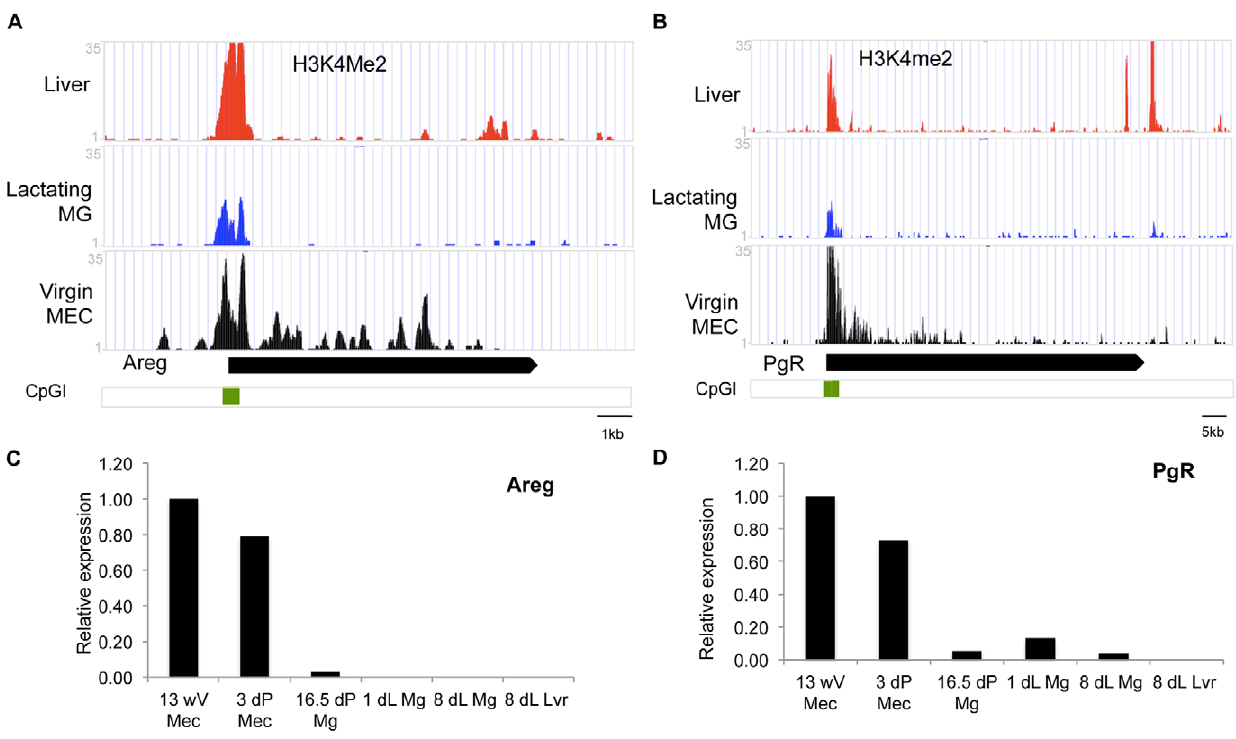
Figure 8. H3K4me2 ChIP-seq and RT-PCR results for genes expressed in virgin mammary gland. ( A–B ): ChIP-seq reads for H3K4me2 in liver tissue ( Liver , red), lactating mammary glands ( Lactating MG , blue) and mammary epithelial cells isolated from 12 week virgin mammary glands ( Virgin MG , black). ( C–D ): Q-RT-PCR of ( C ) Amphiregulin (Areg) and ( D ) Progesterone receptor PgR at different developmental stages in MEC isolated from mammary gland tissue of 13 week virgin (13wV), 3 days pregnant (3dP) or whole mammary tissue from 16.5 day pregnant (16.dP Mg) day 1 and day8 lactation (1dL Mg and 8dL MG) as well as liver from an 8d lactating animal (8dL Lvr). Real-time-RT-PCR data are normalized to Keratine 18 and expressed relative to 13wV